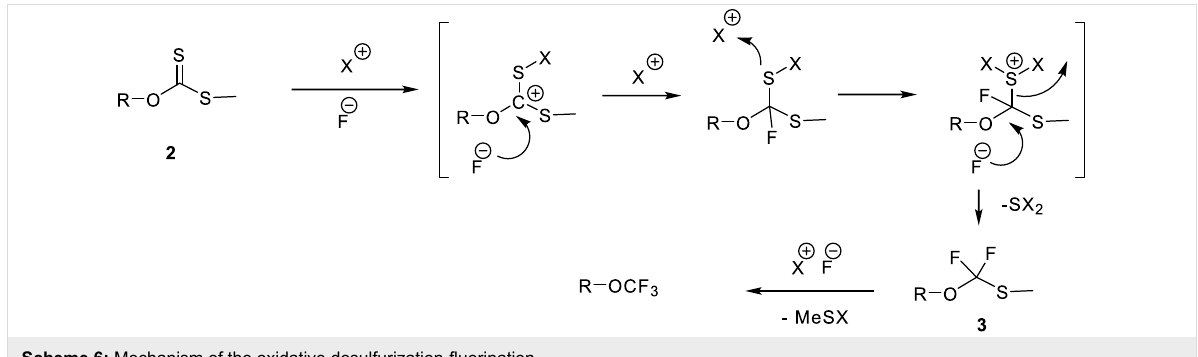
Scheme 6: Mechanism of the oxidative desulfurization-fluorination.